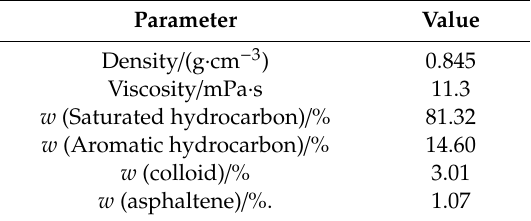
Table 1. Properties of the crude oil obtained from the CQ Oilfield.